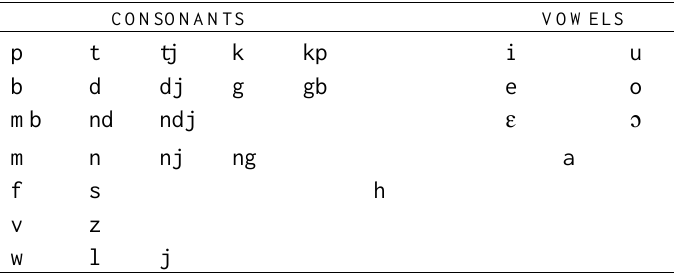
Table VII: Saramaccan phoneme